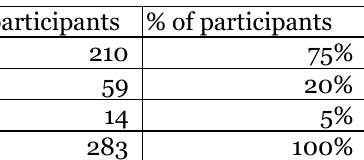
Population Distributed by Discipline Areas